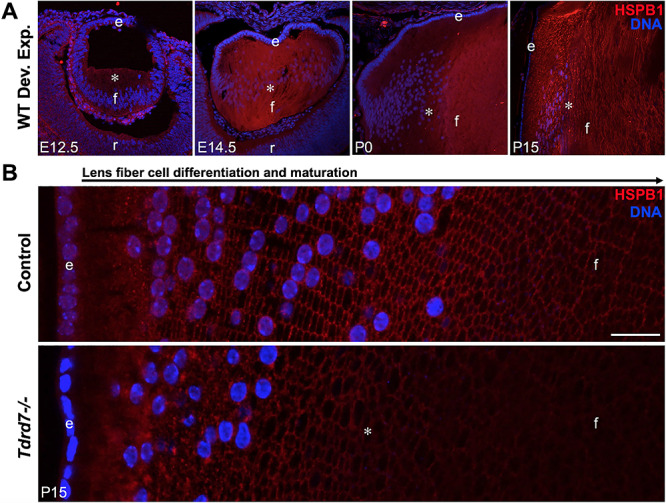
HSPB1 protein staining in fiber cells increases during normal lens development but is reduced in Tdrd7−/− lens fiber cells. (A) To examine HSPB1 protein expression in normal mouse lens development, immunostaining with HSPB1 antibody was performed on sagittal sections of wild-type mouse embryonic lenses E12.5 and E14.5 and postnatal lenses at P0 and P15. HSPB1 is progressively expressed in lens fiber cells during development (asterisk). (B) Cross sections of control and Tdrd7−/− P15 lenses were immunostained with HSPB1 antibody. Reduction in HSPB1 protein staining in Tdrd7−/− fiber cells that have lost their nuclei is indicated by asterisk. DNA (blue) is stained by DAPI. Scale bar indicates 20 μm. Abbreviation: e, anterior epithelium of the lens; f, fiber cells; r, retina.